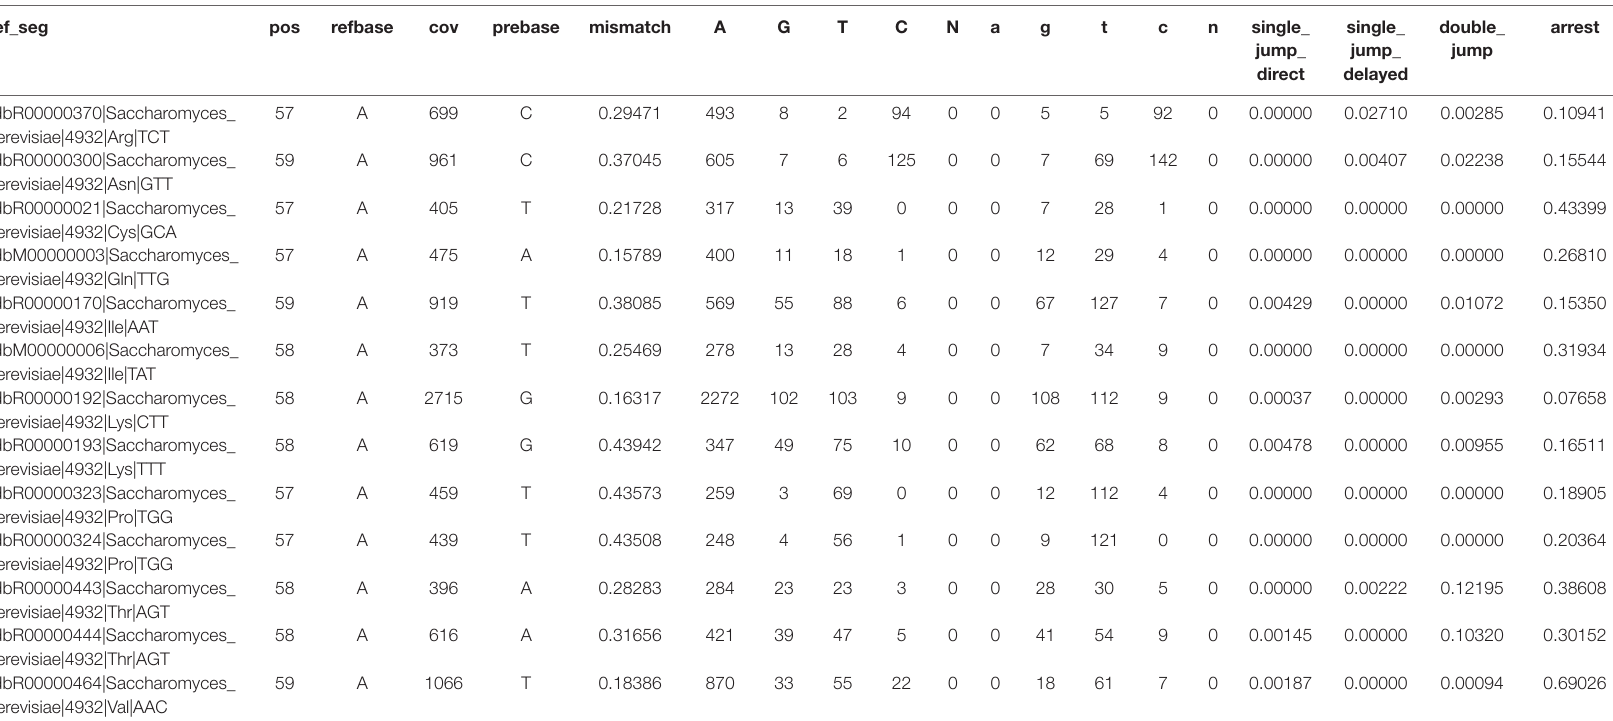
TABLE 1 | Extracted Profile file after filtering with Demethylation_relative_change module with all m 1 A candidate positions.